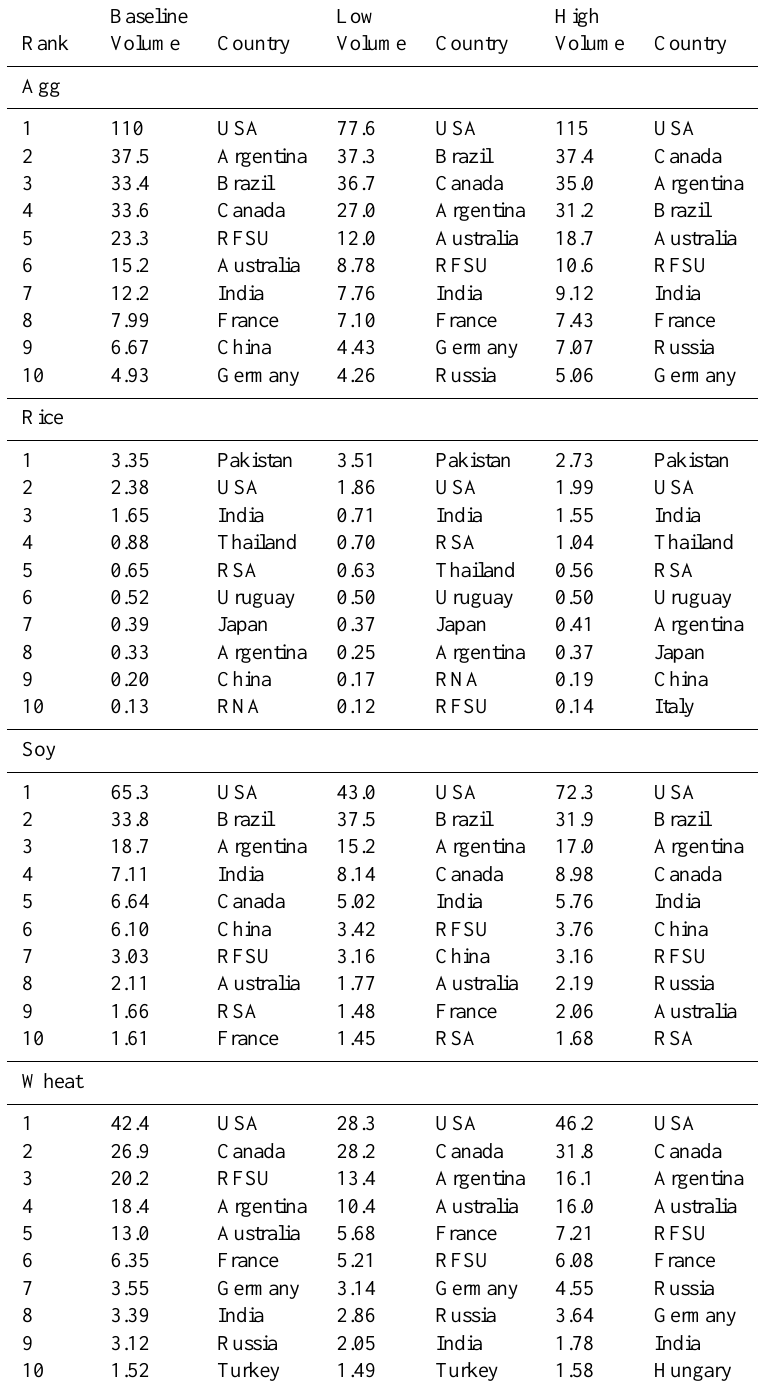
Table 1. Top exporters of virtual water by crop under the baseline, low-, and high-yield scenarios. All values are in billions of cubic meters. RFSU indicates Rest of Former Soviet Union, RSA indicates Rest of South America, RNA indicates Rest of North Africa, Agg stands for